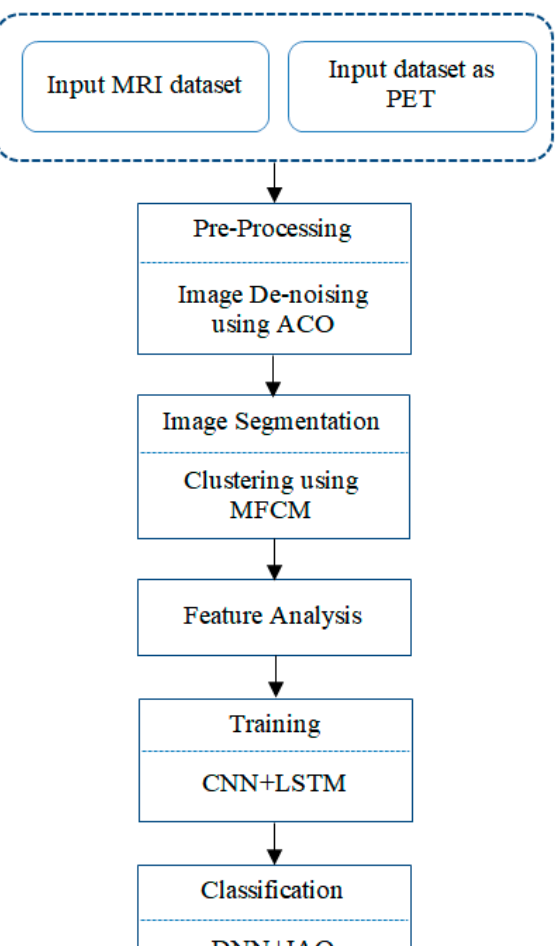
Figure 2. Flow chart for Multi-DL showing the stages of the proposed system involving conventional steps followed: Pre-processing; image segmentation; feature analysis; training; classification.